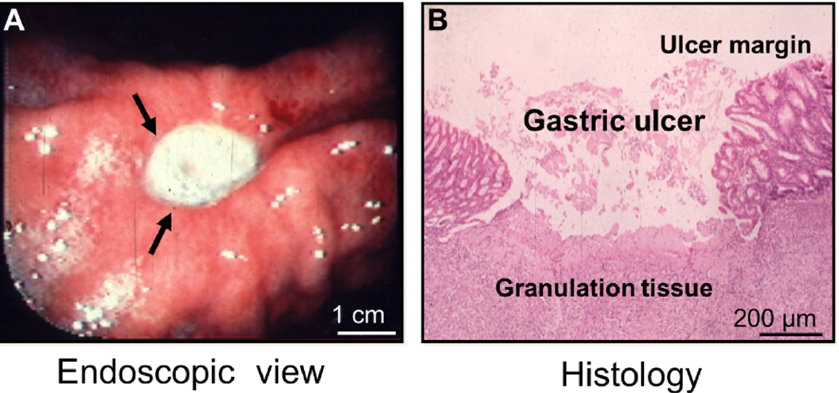
Figure 1. A gastric ulcer—endoscopic view and histology (reprinted with permission from [1]). ( A ) An endoscopic picture of a human gastric ulcer on the lesser curvature of the stomach (arrows). The ulcer is covered with white fibrinopurulent material. ( B ) A histological image of an experimental gastric ulcer in a rat model; hematoxylin and eosin (H&E) staining were used.